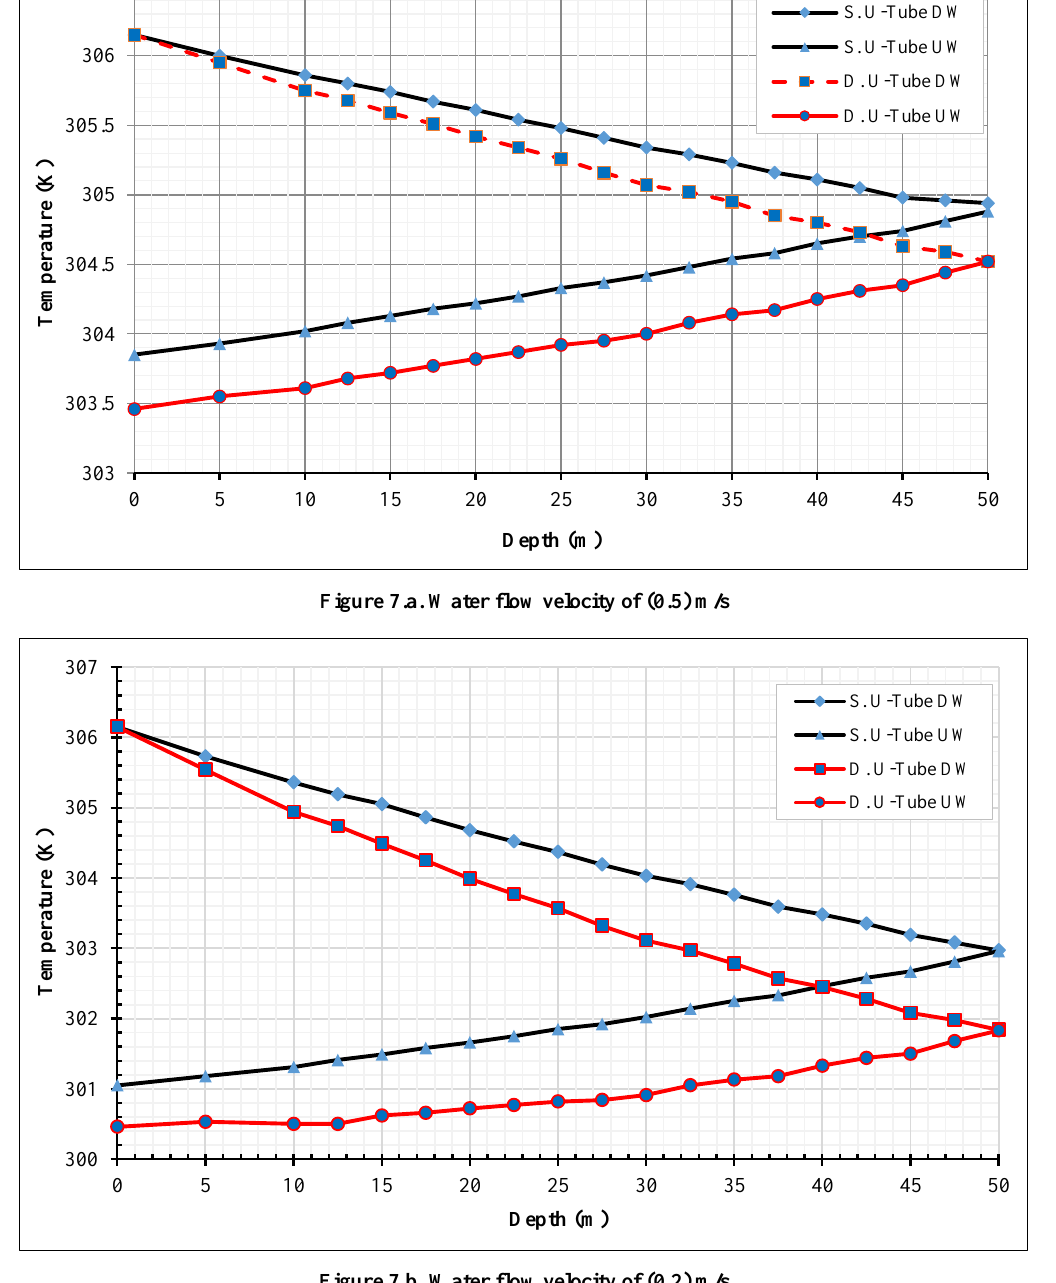
Figure 7.b. Water flow velocity of (0.2) m/s Figure 7. Comparison of water temperature variation with depth for various flow orientations at different flow velocities in the downward side of a single